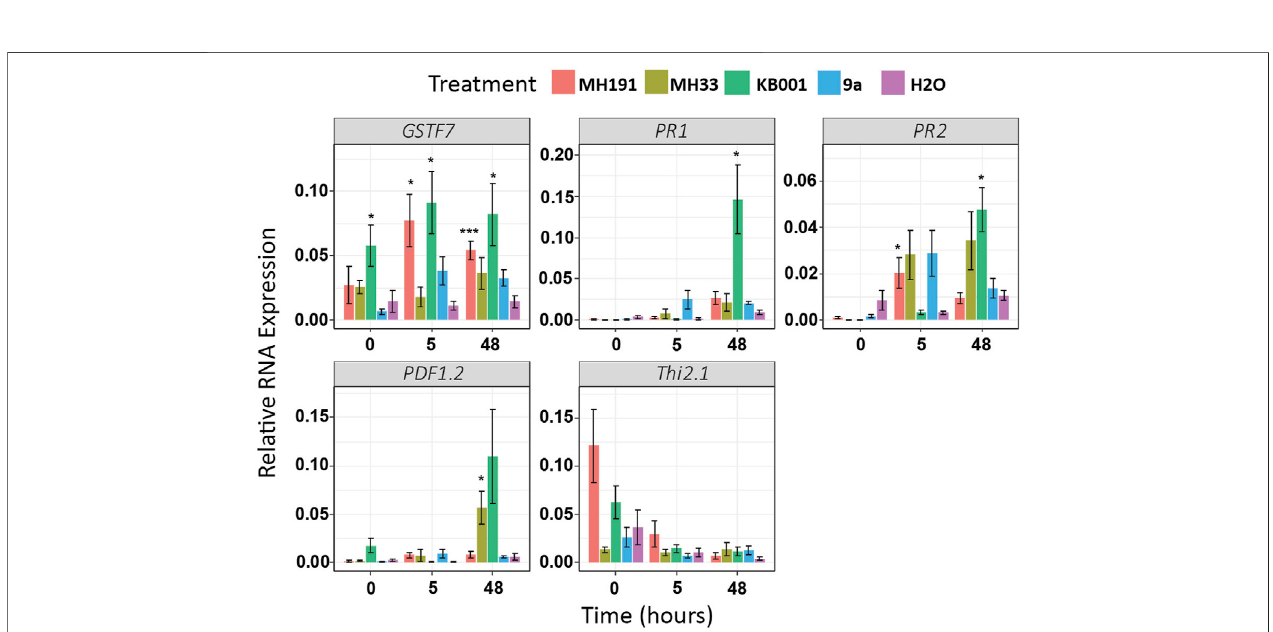
FIGURE3| GeneexpressionofstressmarkersincreasedinActinobacteria-treatedArabidopsisplants.ExpressionlevelsofSA(PR1andPR2)andJA(PDF1.2and Thi2.1) induced stress markers were determined using qRT-PCR. Samples were extracted 3 days after treatment with Actinobacteria but before infection (time (cid:1) 0), 5 and 48 h post Sclerotinia infection. Expression values were averaged, and 6 – 8 biological replicates were normalized to UBC. A t -test was used to determine signi fi cant differences to water treatments. * p < 0.05; ** p < 0.01; *** p < 0.001.